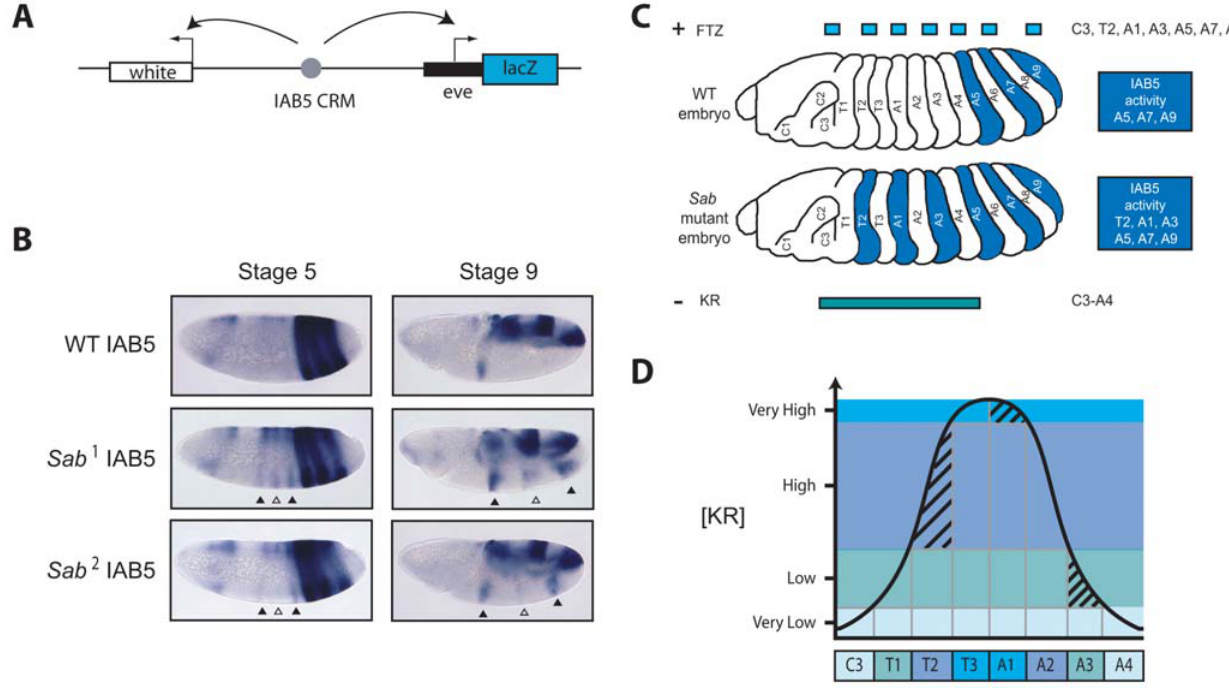
Figure 6. Sab point mutation in a bioinformatically predicted KRUPPEL TFBS in the IAB5 enhancer CRM causes anterior expansion of IAB5 in transgenic embryos. (A) P element construct for functional assays. An IAB5 region (gray circle) from wild-type (WT) or Superabdominal ( Sab 1 or Sab 2 ) mutants is inserted between the white and eve - lacZ reporter genes on the P element reporter construct to test for WT or Sab IAB5 enhancer activity in transgenic D. melanogaster embryos. (B) Transgenic embryos carrying the Sab IAB5 CRMs show ectopic anterior lacZ expression in segments T2, A1, A3. WT IAB5 drives expression of the reporter gene lacZ in the presumptive fifth, seventh and ninth abdominal segments of stage 5 and stage 9 transgenic D. melanogaster embryos. Sab 1 and Sab 2 mutant IAB5 CRMs drive expression of the reporter gene lacZ not only in the presumptive fifth, seventh, andninth abdominalsegments characteristic of IAB5,butectopic expression is also detected inthree additionalstripesin thepresumptivethird (A3) and first abdominal (A1) and second thoracic (T2) segments in transgenic D. melanogaster embryos (triangles). Ectopic expression of lacZ is consistently weaker in A1 (open triangle) compared to that in A3 and T2 segments (filled triangles). This is presumably because KRUPPEL (KR) repressor expression is highest in theA1 segment (see Discussion for more details). (C) IAB5 activity in wild-type and Sab mutantembryos. Theembryonic domains of expression for the IAB5 activator, FTZ (blue) and repressor KR (teal) in wild-type (WT), Sab 1 and Sab 2 (Sab) mutants are indicated. The presumptive abdominal segments in which IAB5 is active are shown in dark blue. In the wild-type embryo IAB5 is active in A5, A7, and A9. IAB5 is not active in even numbered presumptive abdominal segments (A2, A4, A6, and A8), due to the absence of the FTZ activator. In addition, IAB5 is repressed in A1, A3, and more anterior segments due to binding of the combination of the KR, KNI and HB repressor factors. In either of the Sab 1 and Sab 2 mutations, disruption of the single highest scoring KR binding site in the IAB5 CRM alters KR binding and facilitates ectopic activation of IAB5 in A3, A1, and T2 (see Discussion for more details). (D) Model for KRUPPEL protein gradient across the presumptive anterio-posterior segments of the Drosophila embryo. KR repressor concentration is at its peak (very high) in segments T3 and A1 (teal). In T2 and A2 KR concentration remains high (powder blue). In T1 and A3 KR is low (light green) and in A4 and C3 (labial segment) the concentration of KR is very low (light blue). Shading indicates the specific level of KR expression in T2, A1, and A3 segments, where the sole activator of the IAB5 CRM, FTZ, is also expressed. In the Sab mutations, disruption of a highly conserved KR binding sitein theIAB5 CRM altersKR binding andfacilitates IAB5activation in T2 andA3.IAB5-mediated activation of reporter gene expression also occurs inA1, but to a lesser extent due to the very high concentration of KR in this segment (see Discussion for detailed description).